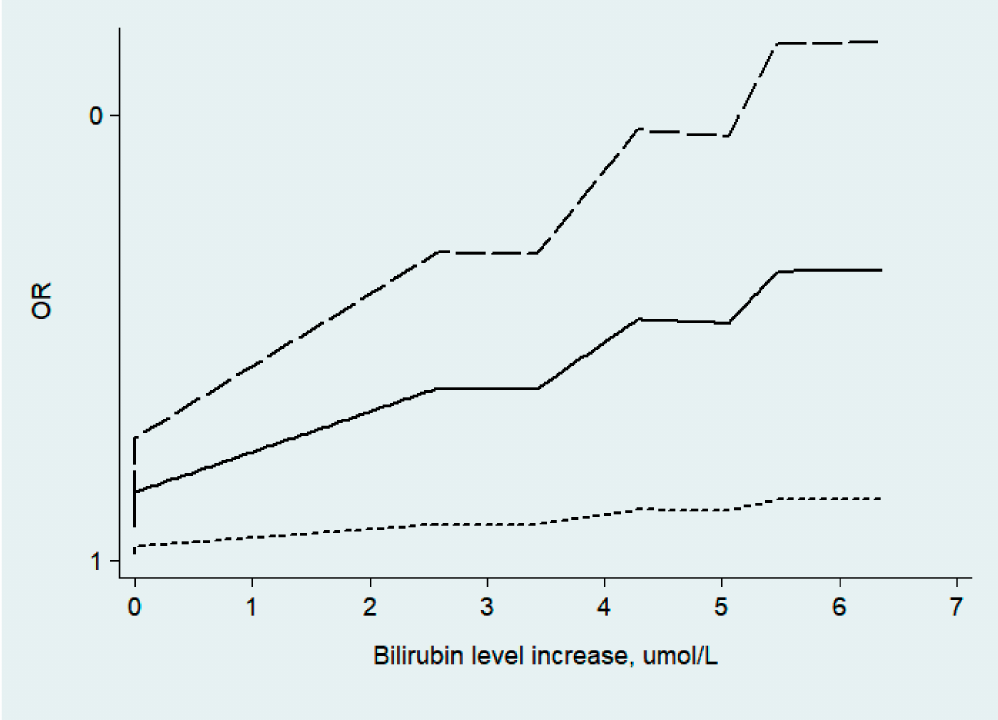
Figure 4. The dose–response relationship between direct bilirubin concentration and ischemic stroke